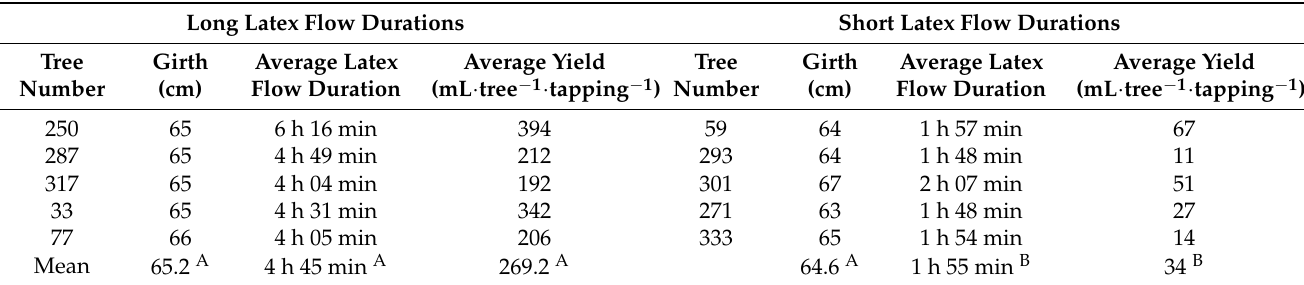
Table 3. Rubber tree information used for different latex flow